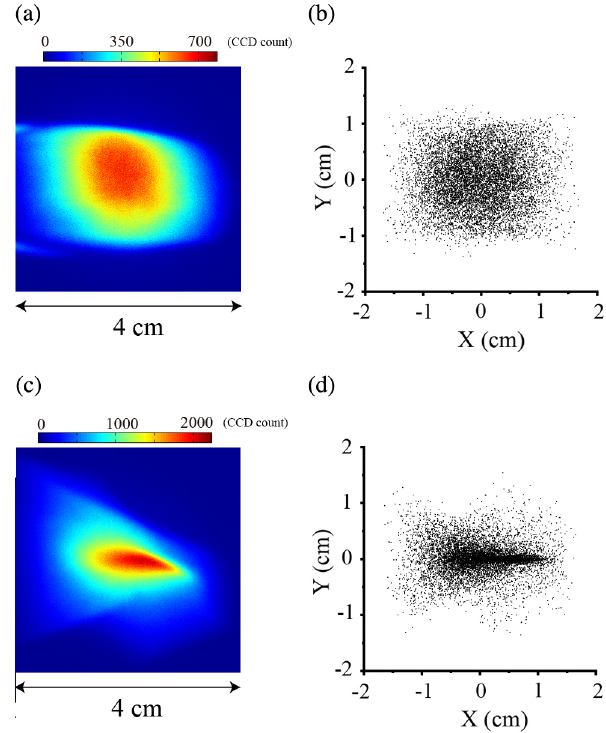
FIG. 6. Control of the beam profile at the irradiation point. Experimental (a) and simulated (b) demonstrations of radially symmetric distributions of 5 MeV proton beams with (cid:1) 1 % energy spread on BPD#3 (using a MCP). Experimental (c) and simulated (d) demonstrations of malformed beam spots with improper focal length of the triplet lens in the y direction.